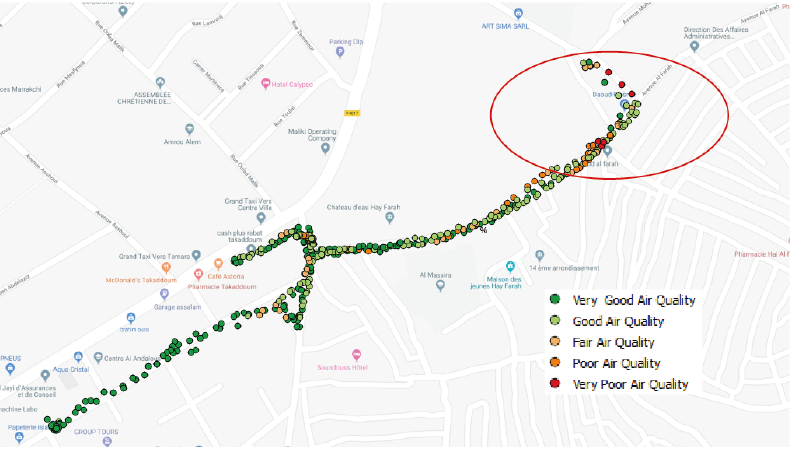
Figure 12. The high PM concentrations recorded in Hay Al Farah,